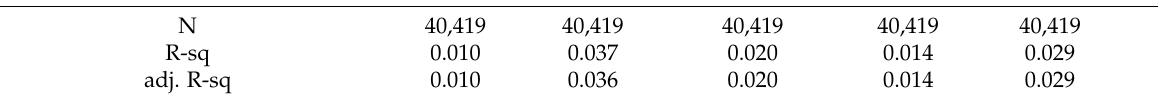
Table A4 reports result assessing the impacts of repeated negative rainfall shocks on key measures of social network relationships. Repeated negative rainfall shocks are districts in India that have experienced consecutive